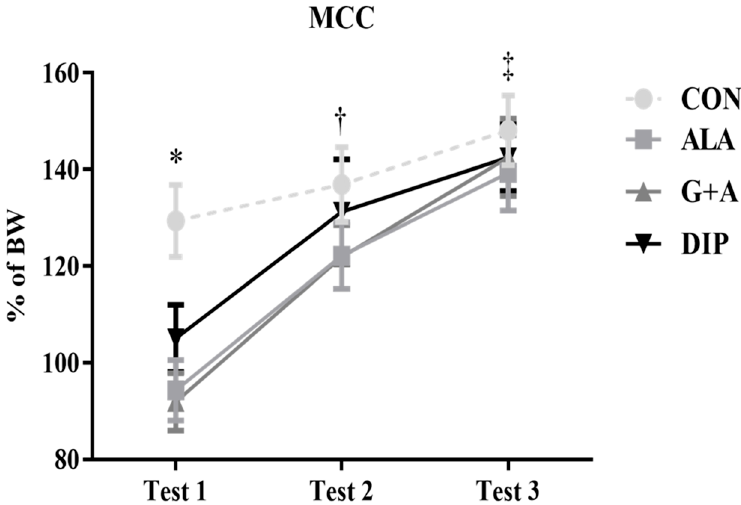
Figure 6. Maximum carrying capacity tests of rats submitted to resistance exercise and supplementation with L -glutamine and L -alanine. SED: sedentary group, CON: trained group, ALA: trained and supplemented with alanine, G + A: trained and supplemented with glutamine and alanine in their free form, and DIP: trained and supplemented with L -alanyl- L -glutamine. * p < 0.05 vs. ALA and G + A. † p < 0.05 vs. test 1. ‡ p < 0.05 vs. test 1 and 2. Data are presented as mean ± SD.